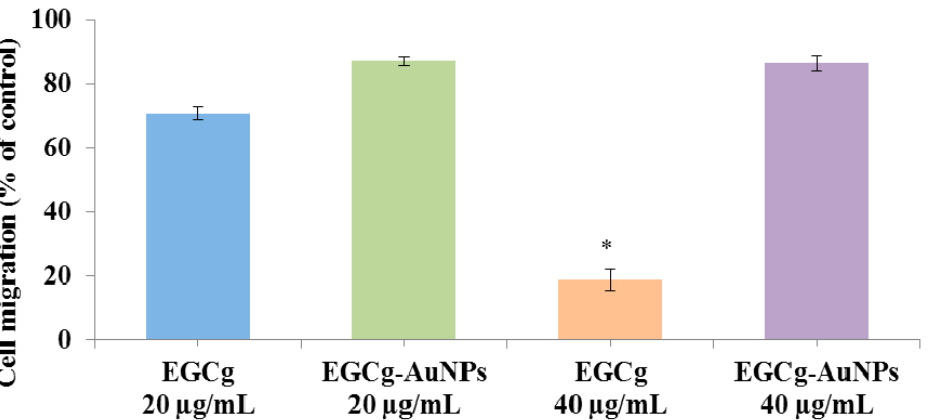
Figure 9. Effects of EGCg-AuNPs and free EGCg on HAECs migration with 24 h incubation time; mean ± SE ( n = 3). * p < 0.05 vs EGCg-AuNPs at same concentration. HAECs (Human aortic endothelial cells).